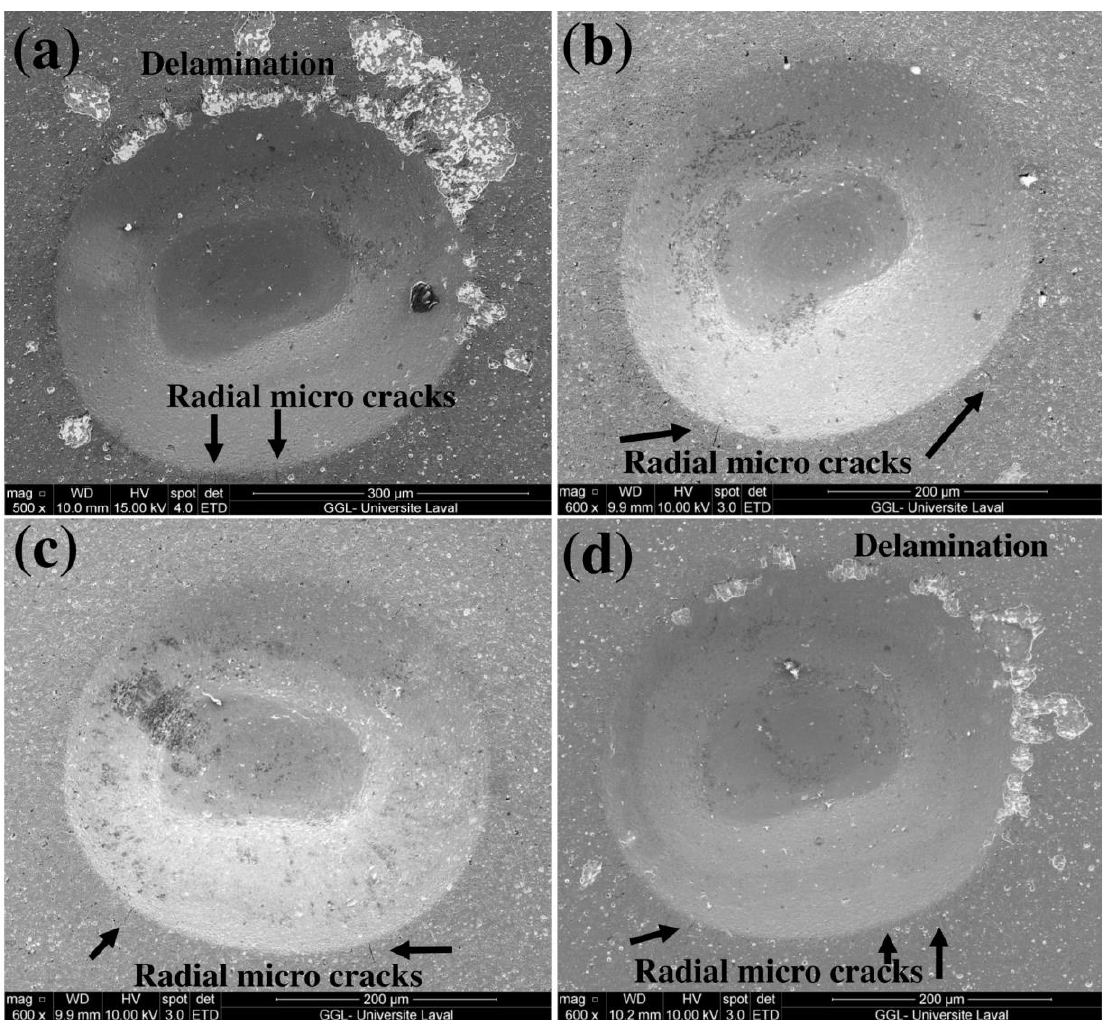
Figure 9. SEM micrographs of Daimler – Benz adhesion tests carried out on coated carbide substrates ( a ) CrN/CrCN/DLC, ( b ) CrN/AlTiN, ( c ) CrN/CrCN, and ( d ) CrCN/TiSiCN. SEM micrographs at higher magnification of the specimens used to carry out the CrN/AlTiN and CrN/CrCN coatings are classified in the HF1 adhesion level denoting Daimler – Benz adhesion tests clearly show the presence of radial micro cracks around the high adhesion strength. A few radial micro cracks were observed in the vicinity of the imprint of the tested coatings (Figure 10). imprints of both coatings as a typical failure, demonstrating the relaxation of stress at boundaries between layers (Figure 9b,c). The cracks most likely stemmed from tensile stresses associated with the material piling up during the test, which relates to hard and brittle coatings [33]. CrCN/TiSiCN coating is in the HF3 category indicating a good adhesion